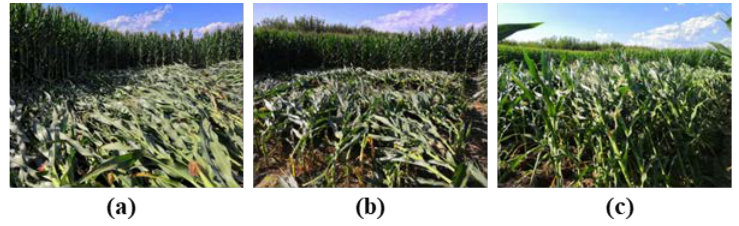
Figure 2. Diagram of lodging. ( a ) RL: root lodging. ( b ) SF: stem folding. ( c ) ST: stem tilt.